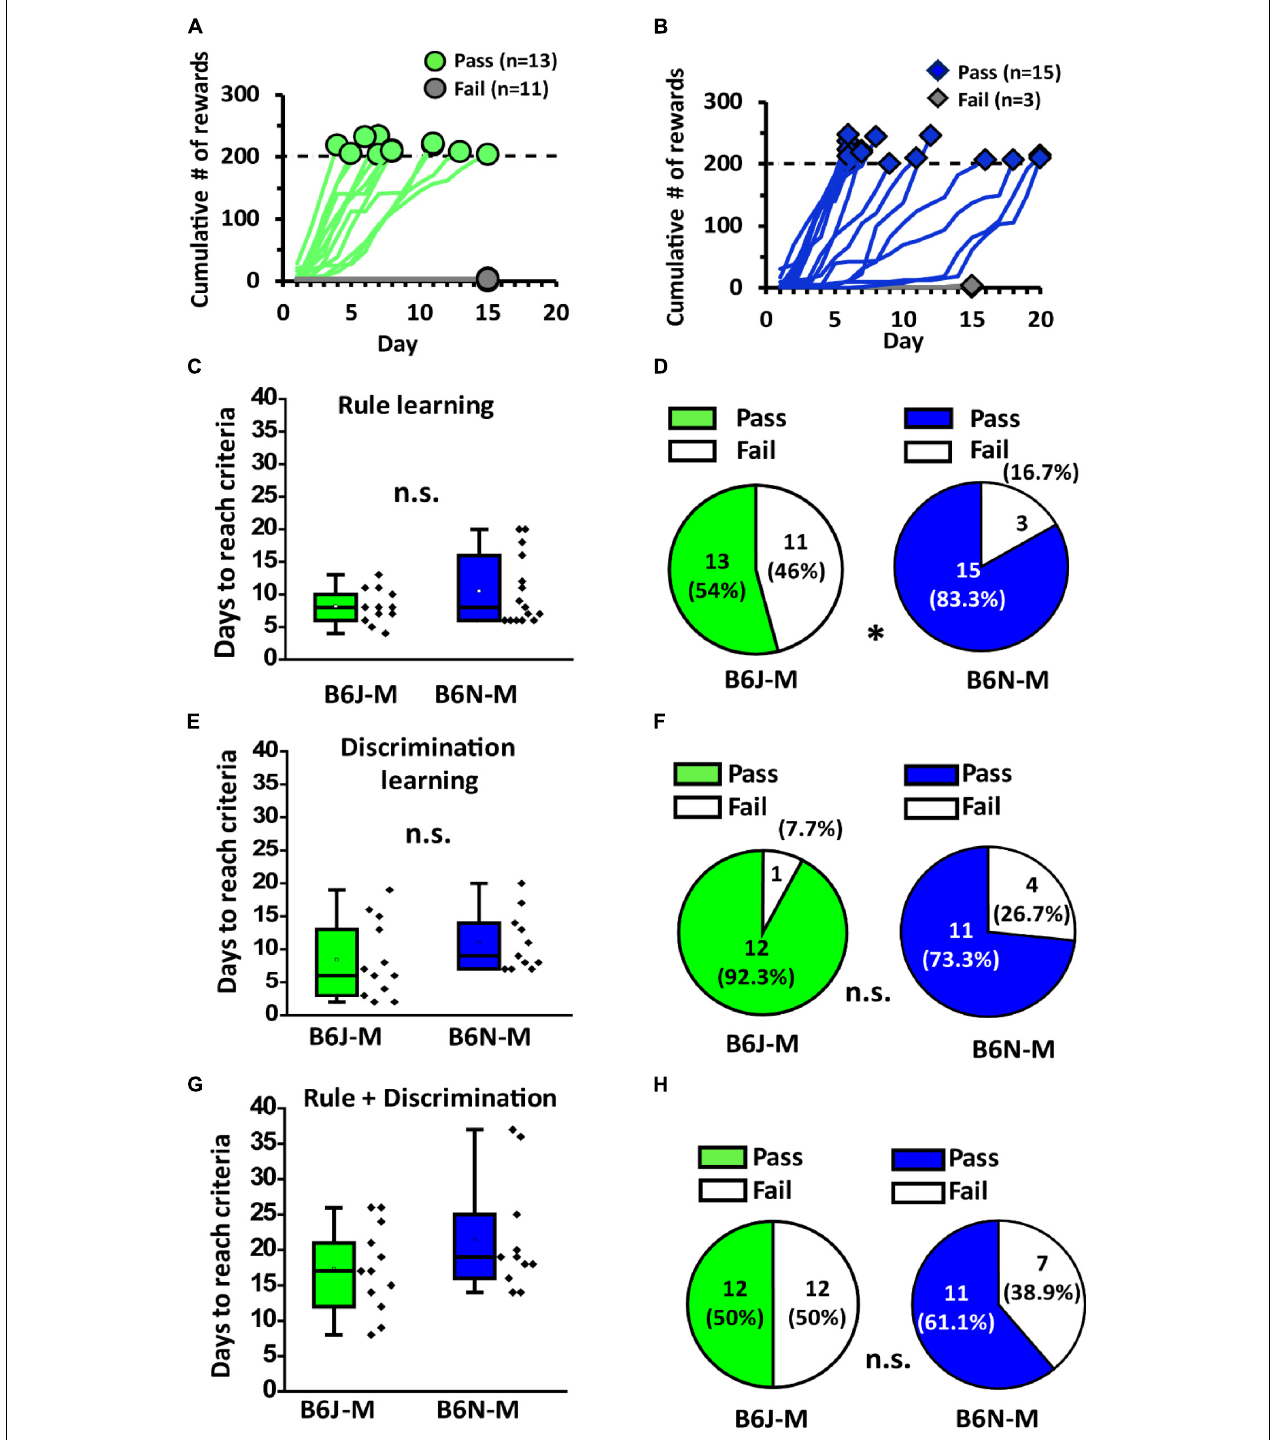
FIGURE 5 | Performance of B6J and B6N mice in training for olfactory two-alternative choice task during mature adulthood. (A,B) Learning curves of B6J-M and B6N-M mice in rule learning. (C) The numbers of days the B6J and B6N mice used to pass rule learning. (D) Pass percentages of B6J and B6N mice in rule learning stage. (E) The numbers of days the mice used to pass discrimination learning. (F) Pass percentages of the B6J and B6N mice in discrimination learning stage. (G) The numbers of days the B6J and B6N mice used to pass the whole task. (H) Pass percentages of B6J and B6N mice in olfactory two-alternative choice task during mature adulthood. ∗ p < 0.05. n.s.,